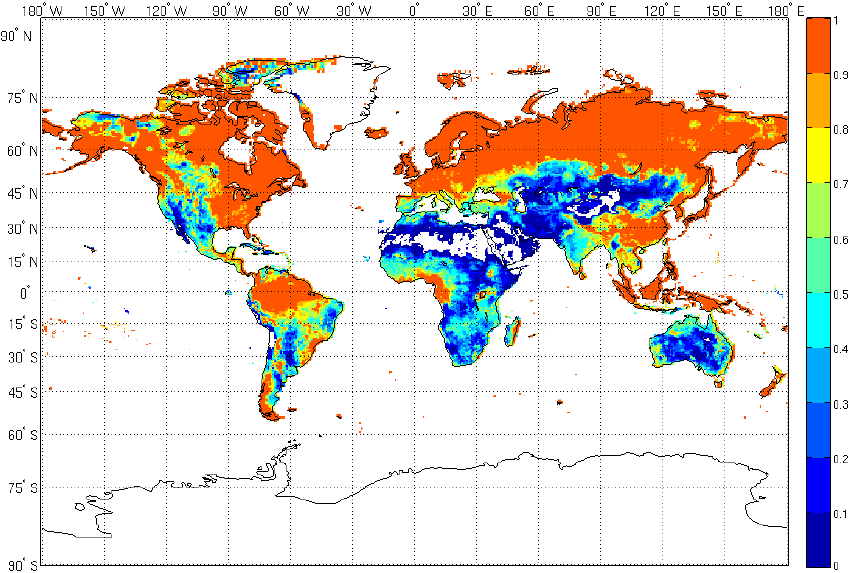
Figure 6. Spatial distribution of the soil moisture dependence factor γ SM for isoprene emission. Annual average for the year 2003.